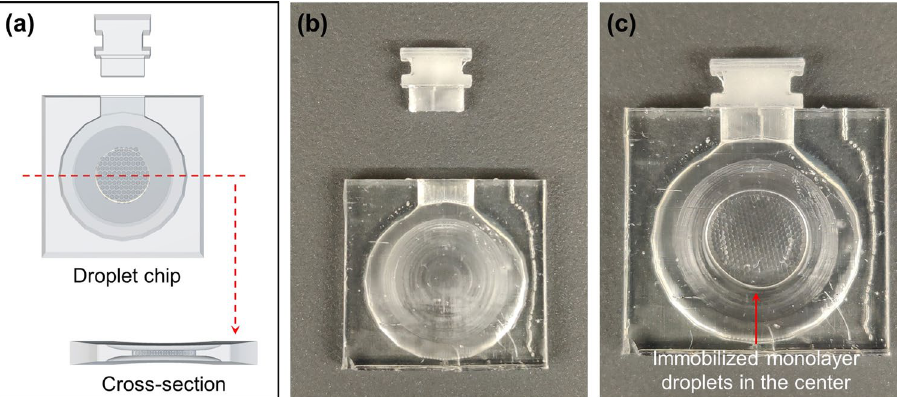
Figure 6. A 3D printed droplet assembly and imaging chip with matched plug: ( a ) the 3D model of the chip and the cross-section to show the shallow center design; ( b ) a printed chip; ( c ) monolayer droplets immobilized inside the chip for subsequent handling and imaging. The droplets will stay still away from the walls inside the chip because of the sloping interior chamber height towards the center. The exterior dimension of the droplet imaging chip is 20 mm × 20 mm × 2.5